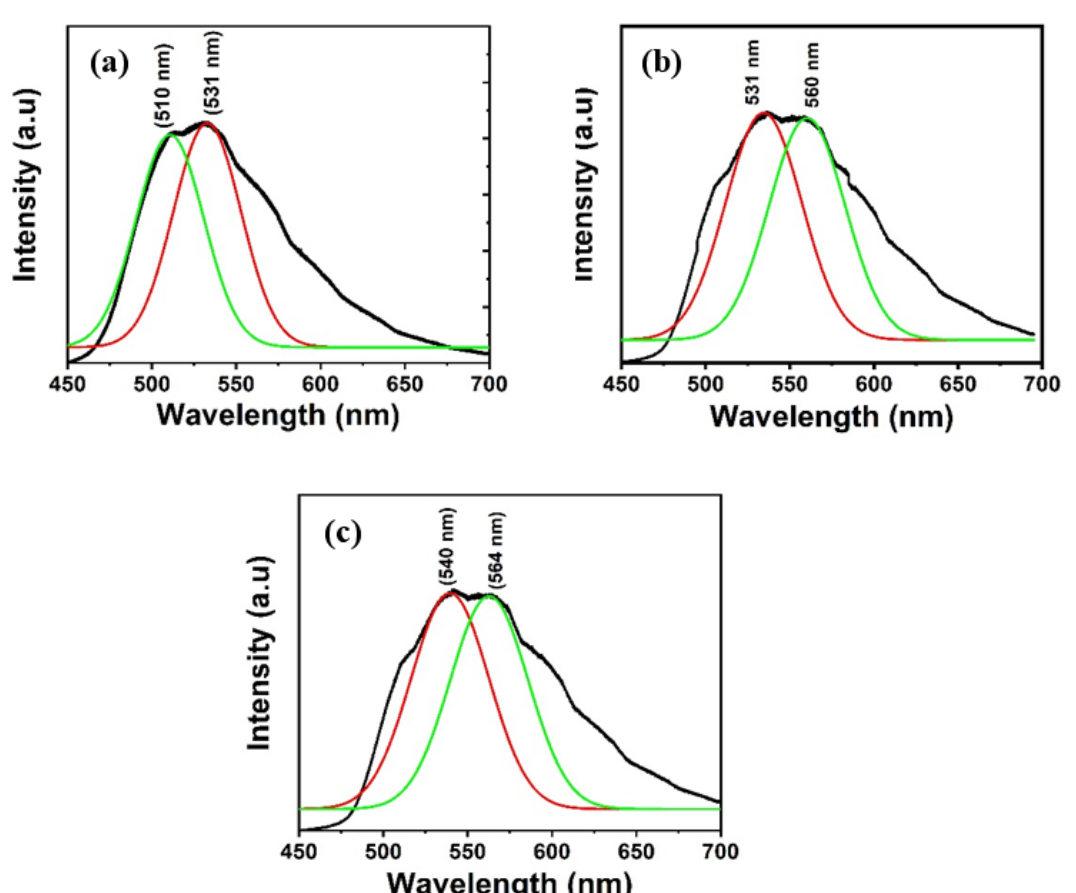
Figure 5 . ( a ) Flurecence of pure Alq3 and Alq3-ZnO nanohybrids under UV excitation ( b ) PL emission spectrum.